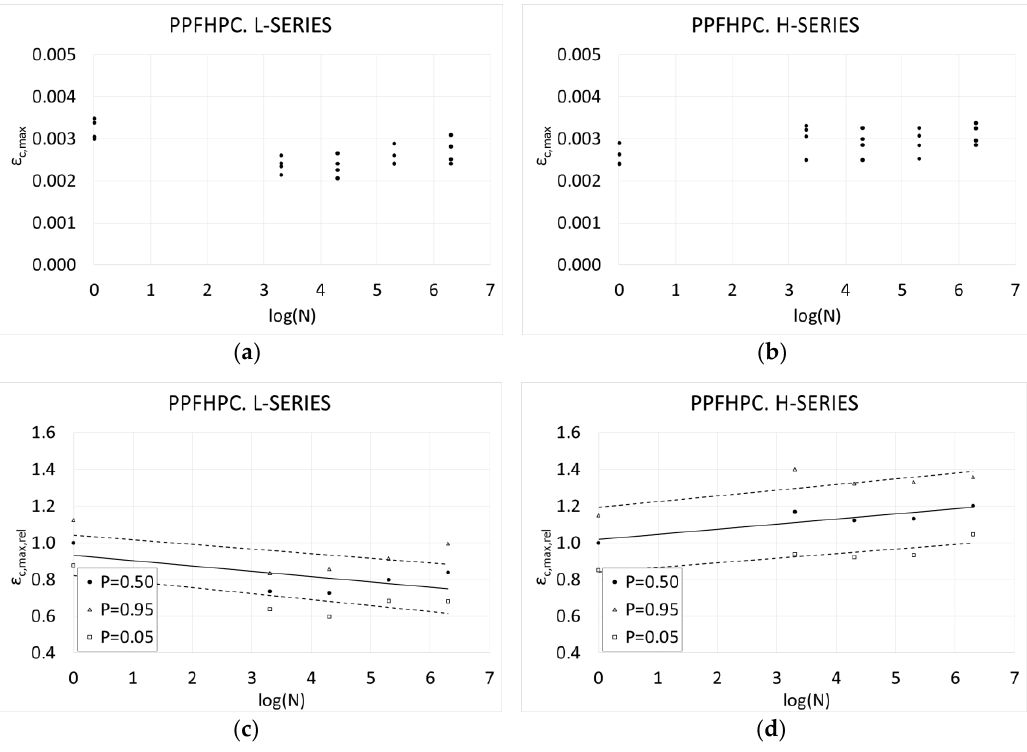
Figure 12. Range of the maximum compressive strain by number of cycles. PPFHPC ( a ) L-Series. Raw